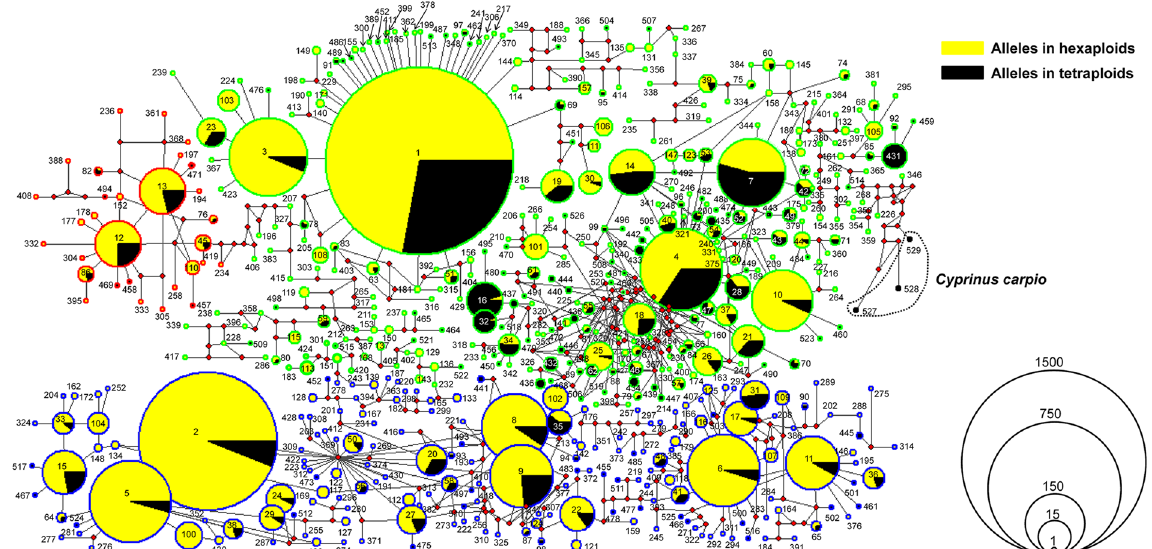
Figure 5. Median-joining network of 526 tf alleles identified from Carassius species complex. Three tf alleles from Cyprinus carpio are used as outgroup. Circles represent different alleles and their corresponding occurrence frequency in all sampled populations. Lineage A, B and C are exhibited in red, green and blue of border colors respectively, which also stand for phylogroups A, B and C in Fig. S2. Yellow and black colors inside the circle show the percentage of hexaploid and tetraploid respectively. Allele codes are denoted inside or beside the circles. Solid red spots represent un-sampled or predicted